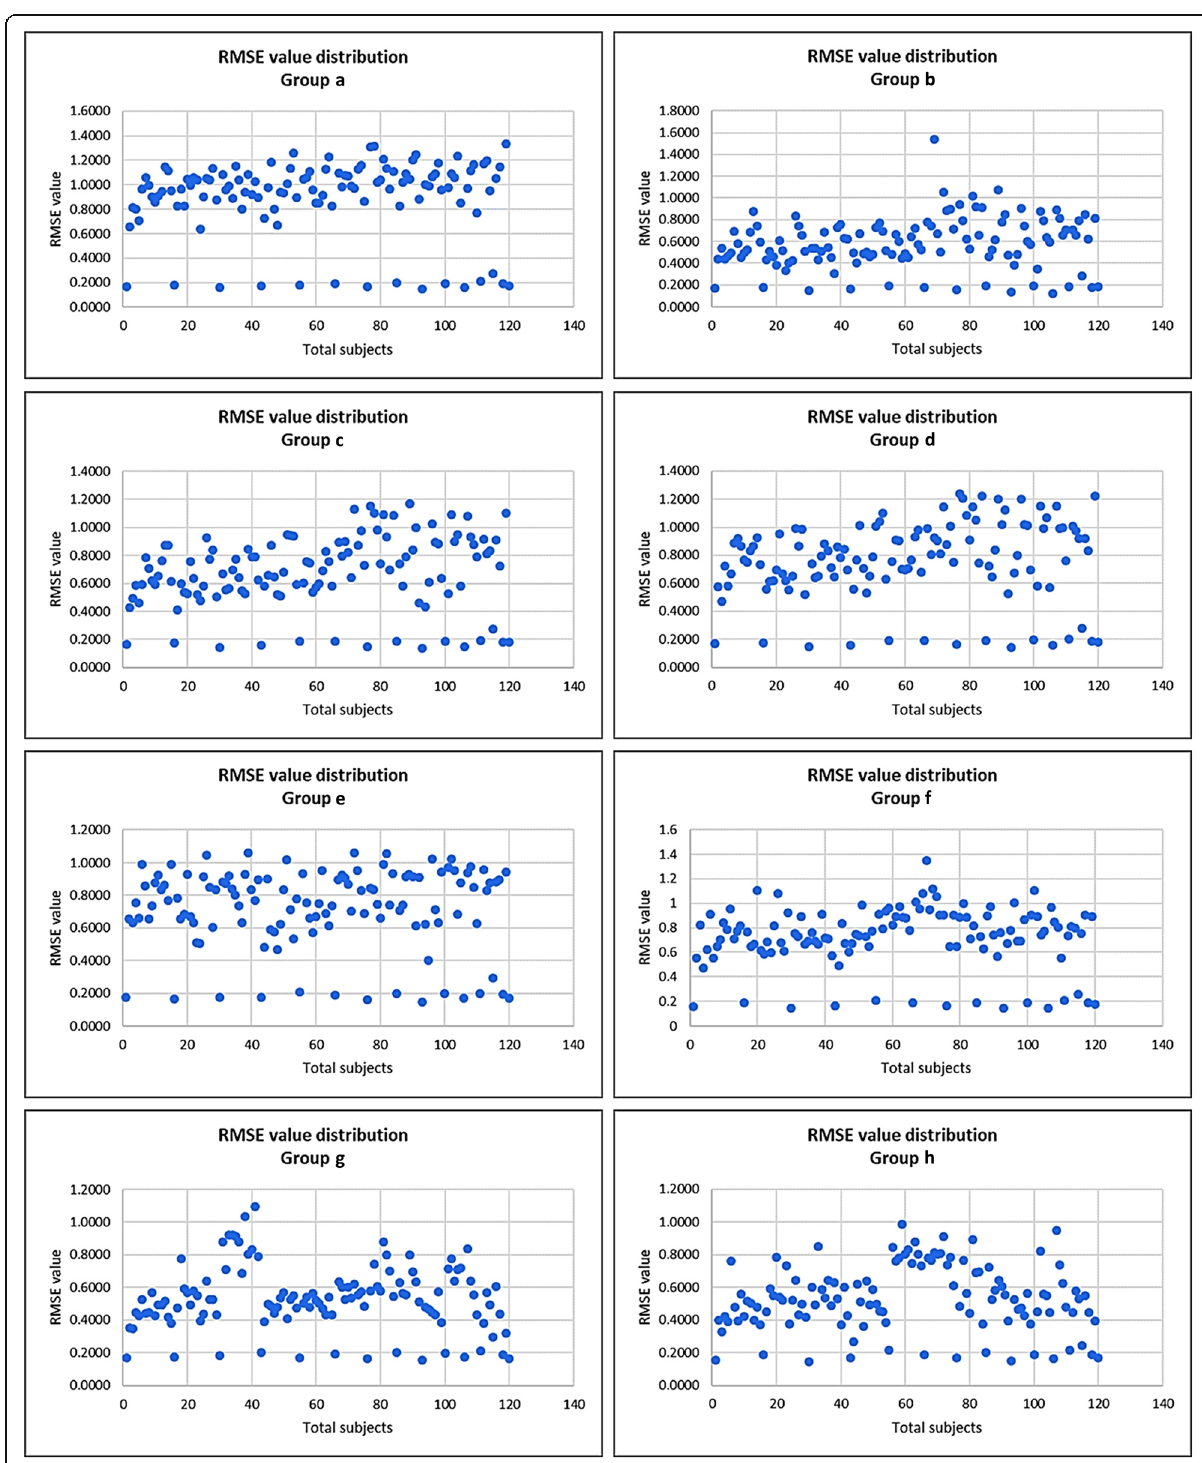
Fig. 7 Scattered plot diagram of experiment 1 (Groups a – h ). Full arch ( a ); partial arch from the left to the right second incisor ( b ), the left to the right canine ( c ), the left to the right first premolar ( d ), the right central incisor to the right last molar ( e ), the left central incisor to the left last molar ( f ), the right second premolar to the right last molar ( g ), and the left second premolar to the left last molar ( h